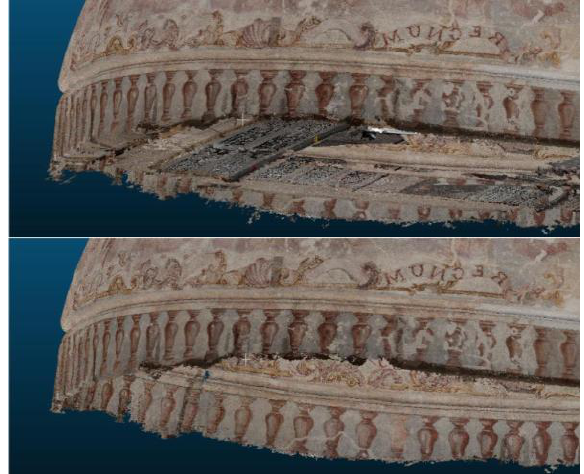
Figure 4: The result of the MVS point cloud